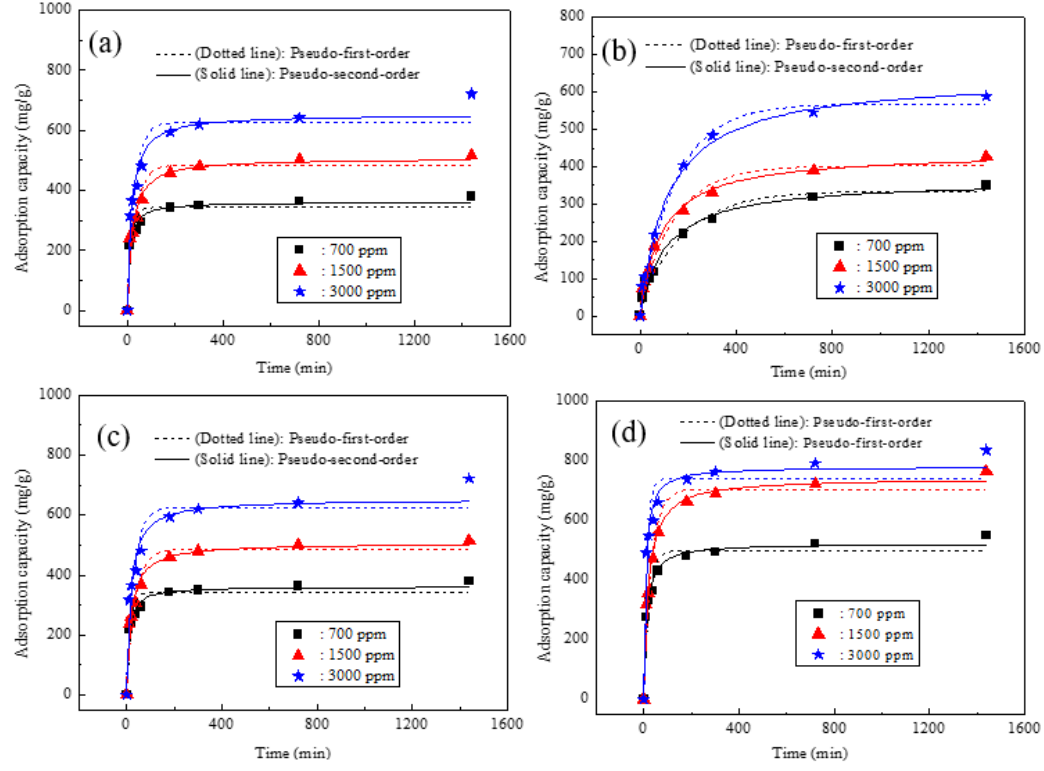
Figure 5. Kinetic adsorption curves with different concentrations of Pb 2+ in raw steel slag and the nanocomposite samples prepared with different additions of MDP: ( a ) raw steel slag (S0), ( b ) S1 (0 g MDP), ( c ) S2 (10 g MDP), and ( d ) S3 (30 g MDP).